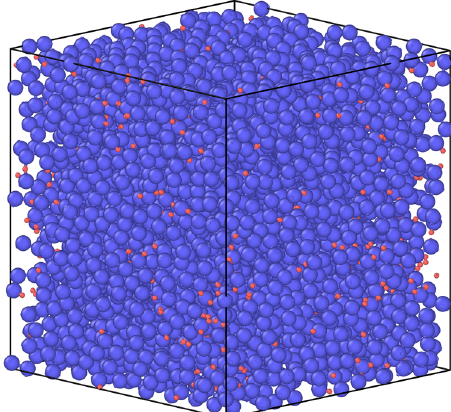
Fig. 8 a-Si:H supercell, with 4096 Si atoms and 558 H atoms. Simulations of this size are utterly inaccessible by DFT calculations. The Si – H GAP makes it possible to create exceptionally large samples, and thus to determine quantities that would be missed by smaller DFT simulations, an example of which is the statistical distribution of void sizes.